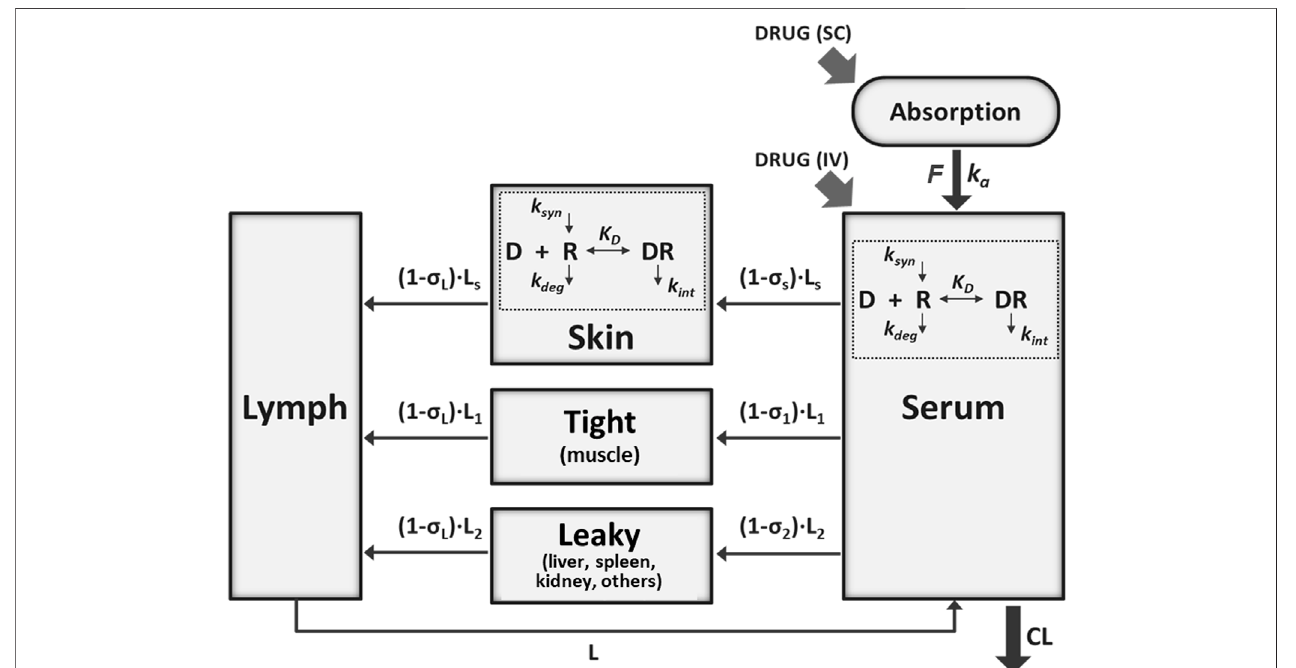
FIGURE 1 | Schematic of the minimal physiologically-based pharmacokinetic (mPBPK) model for secukinumab and ixekizumab incorporating IL-17 binding in serum and skin. See Table 2 for model parameter values.